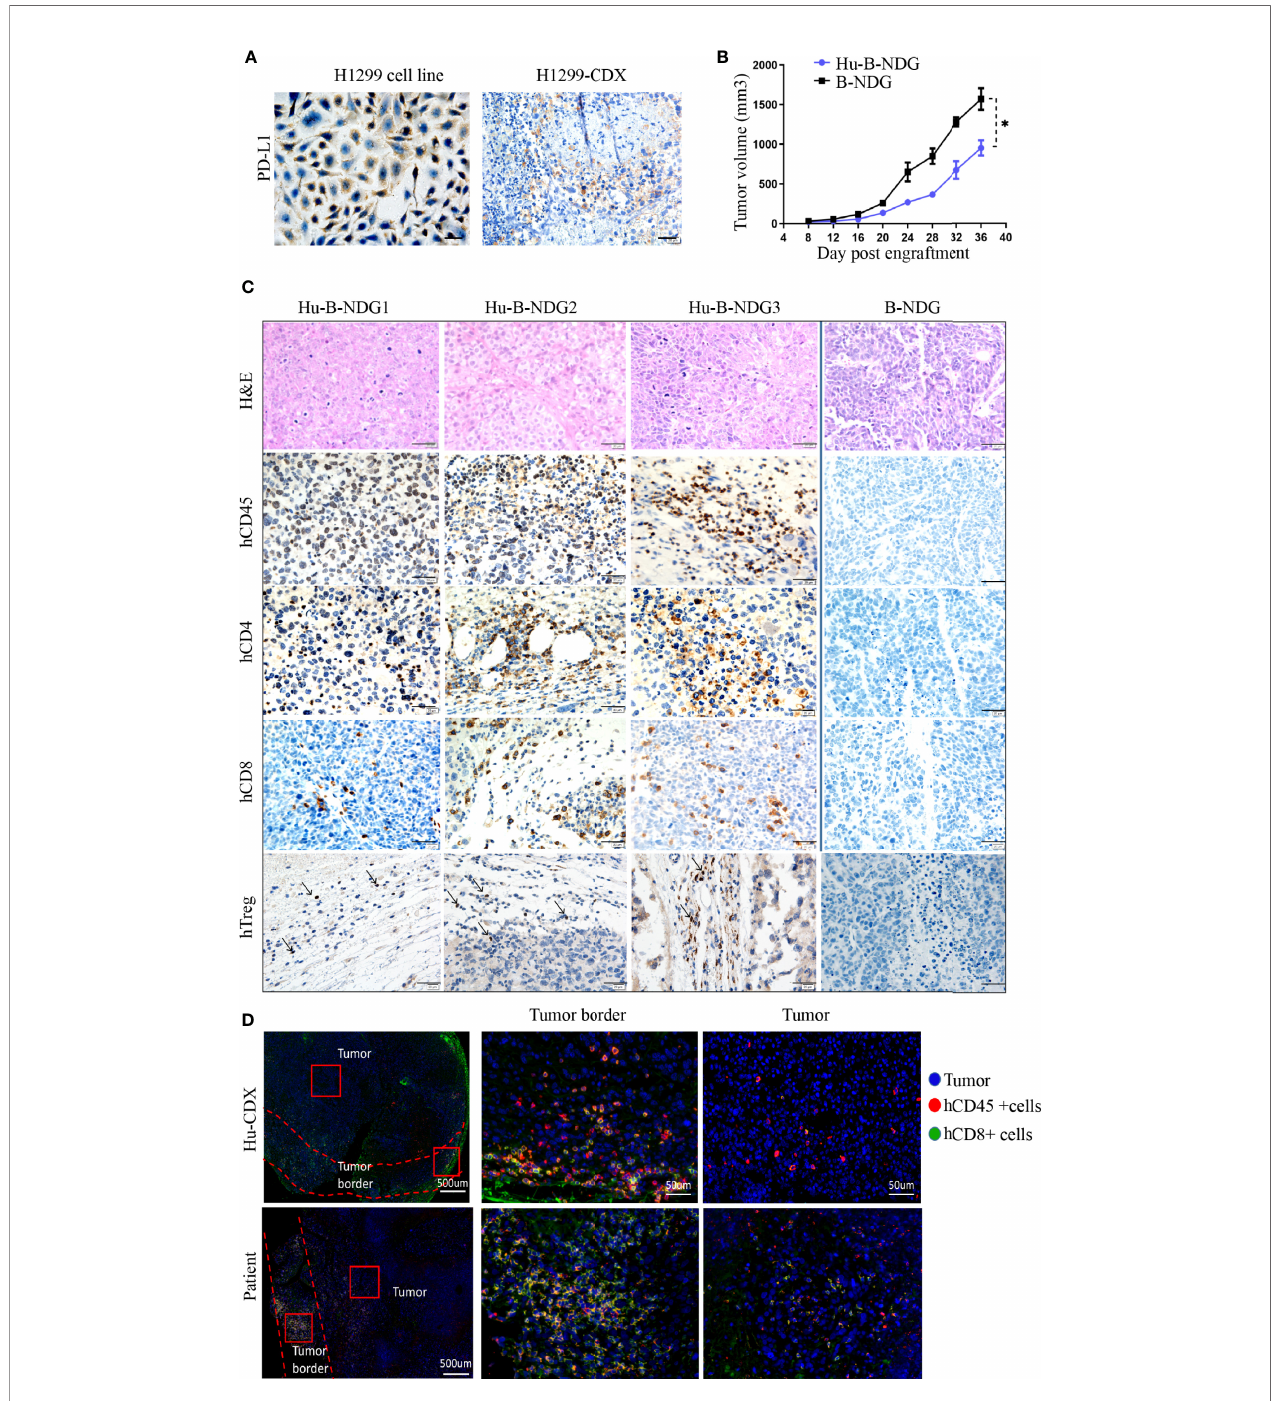
FIGURE 3 | Growth of NSCLC CDX in Hu-PBMC-B-NDG mice. (A) Immunohistochemical analysis of PD-L1 expression in H1299 cell line and CDX. (B) Growth curve of H1299 cell line on B-NDG and Hu-PBMC-B-NDG mice.Data are presented as the mean ± SD of the volume of CDX (mm 3 ); n = 5. *P<0.05. (C) Immunohistochemistry for CD45, CD8, CD4,Treg(Foxp3) and H&E stains in three tumours from humanzied B-NDG mice and one tumour from B-NDG mice are shown. Representative images were taken at 40x magni fi cation and the scale bar denotes 20 mm. (D) Immuno fl uorescence was used to analyze the immunocyte in fi ltration in the center and border of tumors from Hu-PBMC-CDX and clinical patients. Representative images were taken at 40x magni fi cation and the scale bar denotes 50